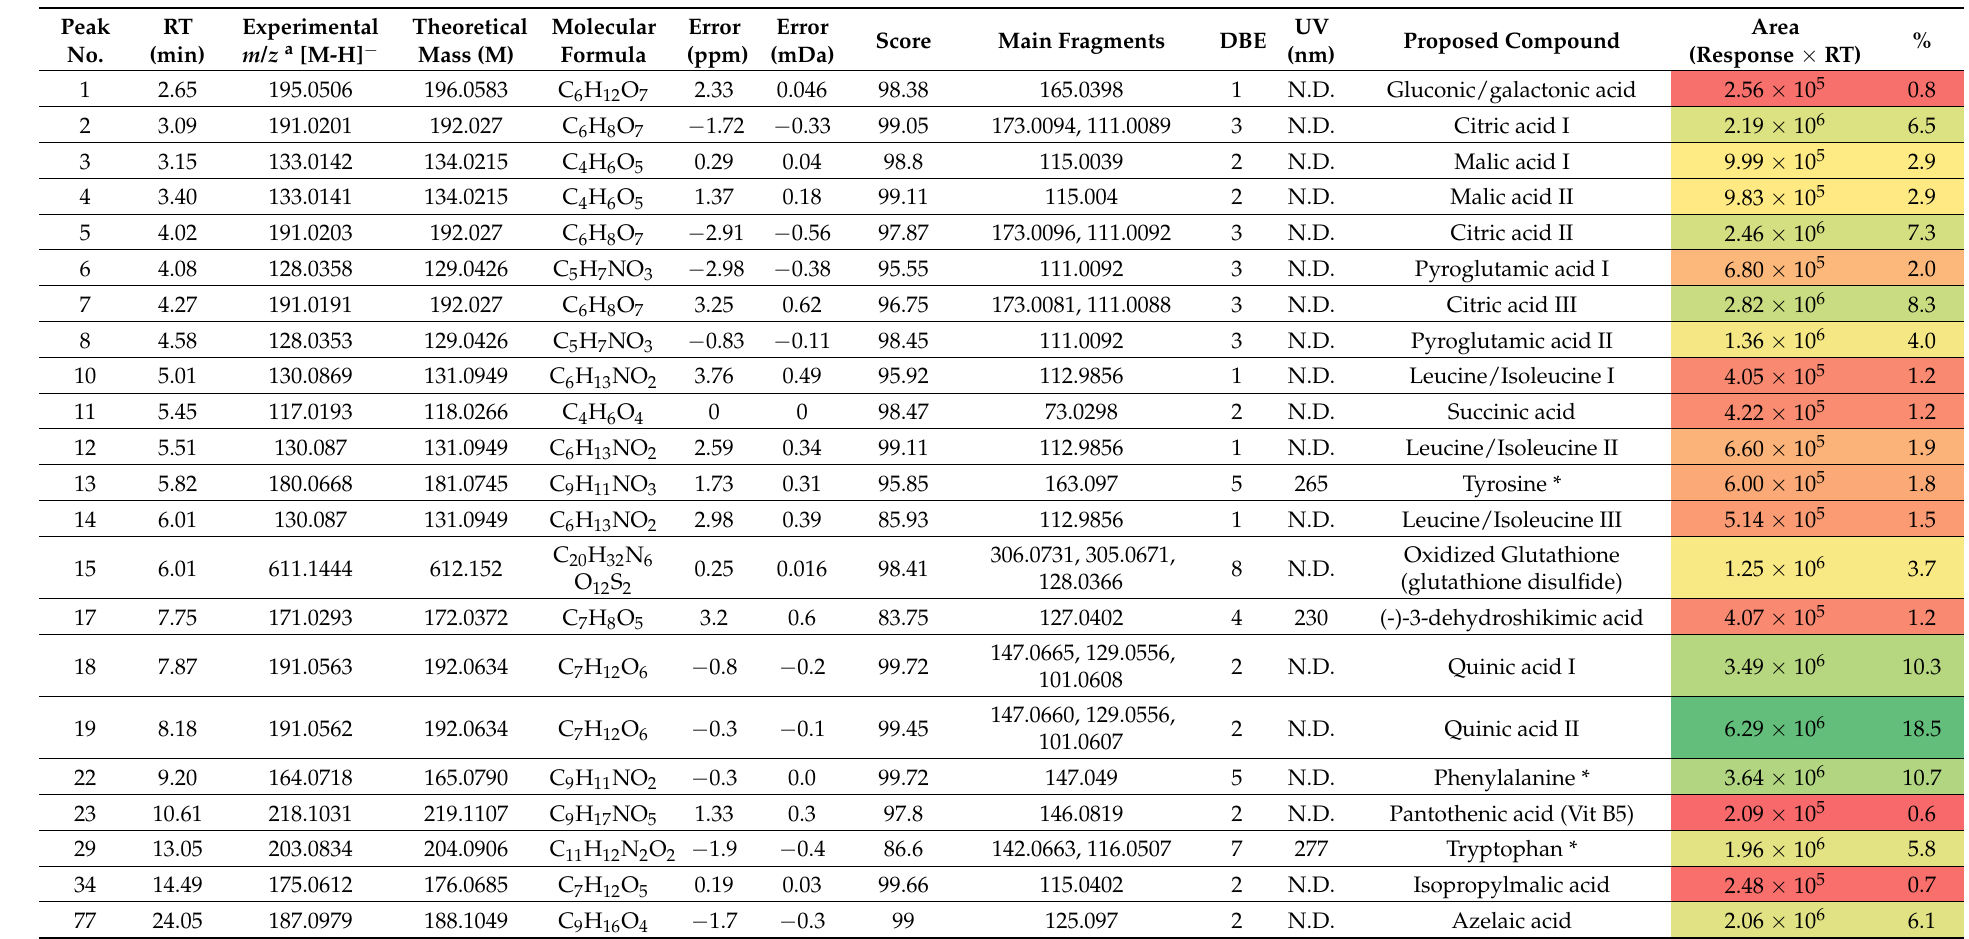
Table 2. Non-phenolic compounds characterized in SG32